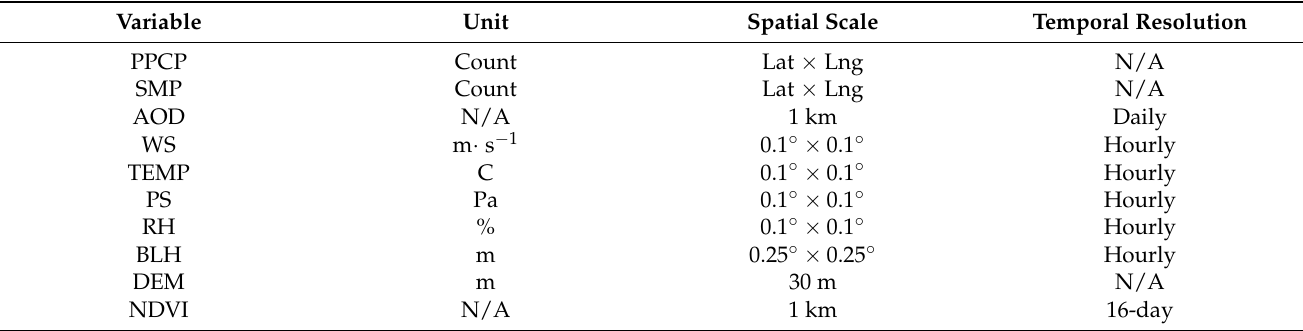
Table 1. List of data used in this